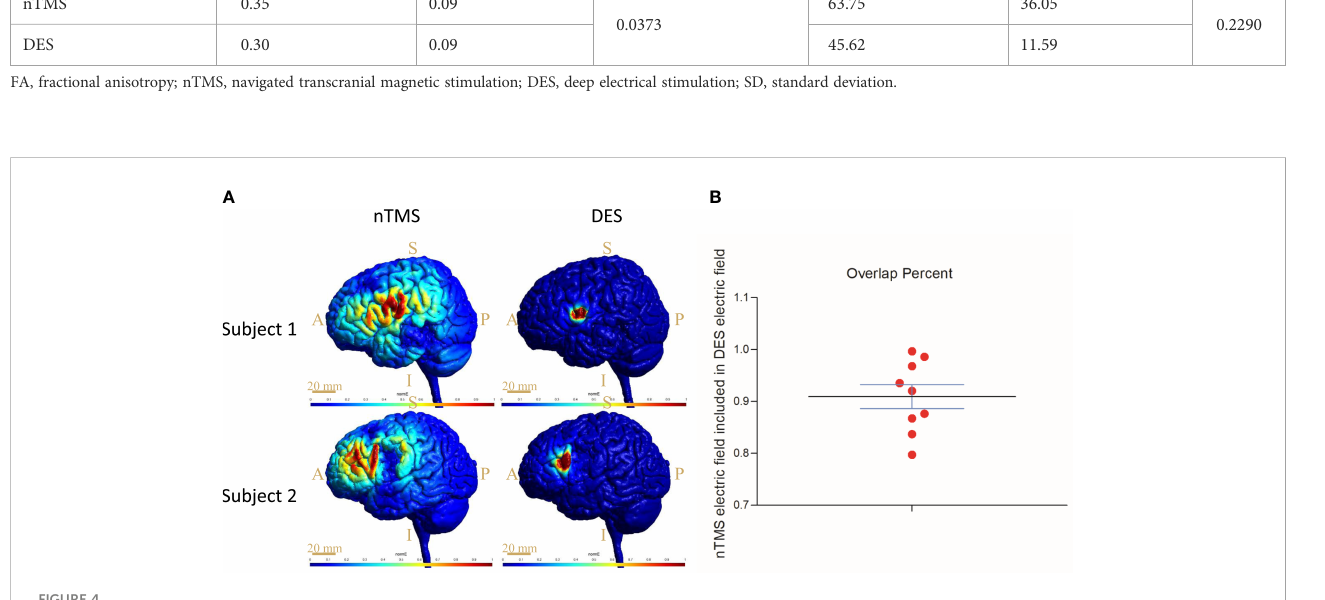
shown in Figure 2, the comparison between spatial distribution of nTMS-positive sites and DES-positive sites was completed in nTMS